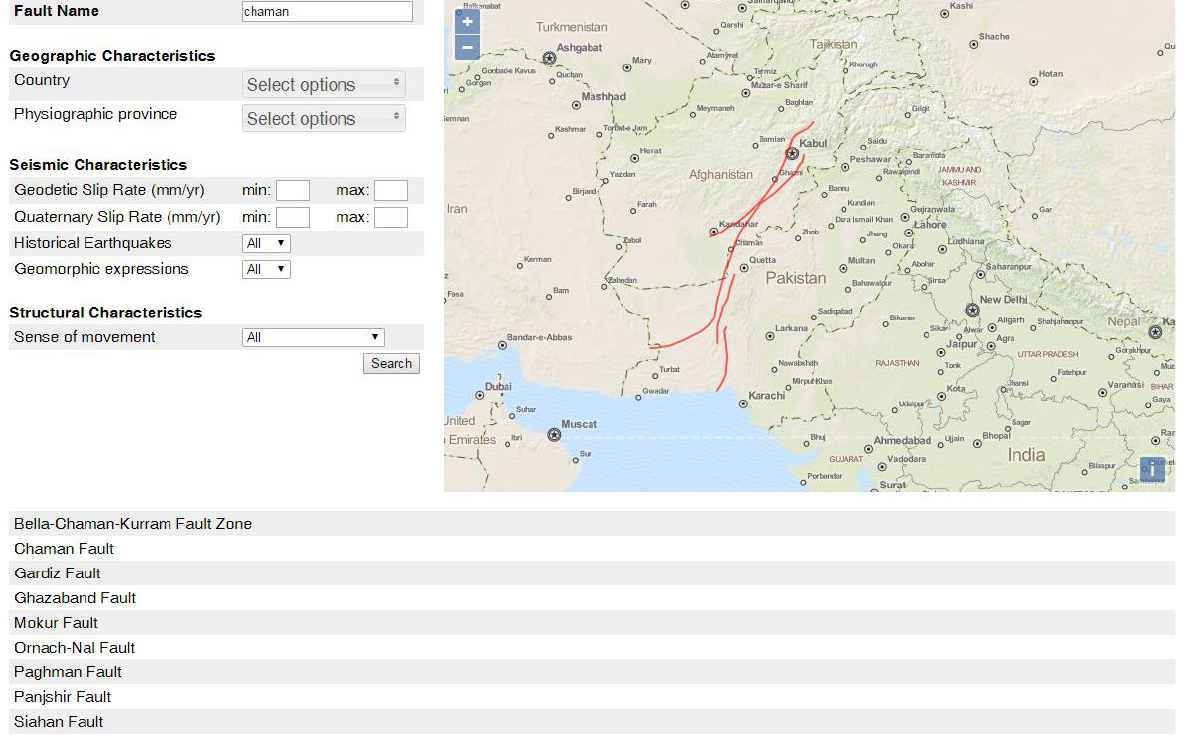
Figure 7. The database search tool allows users to search and sort fault information on a variety of fields. The above example shows search results for the Chaman Fault. The search yields results relevant to the Chaman fault including faults that are considered to be part of its extensions. These results are shown as a list and can be visualized on the map. Fault names and locations are linked to relevant fault information